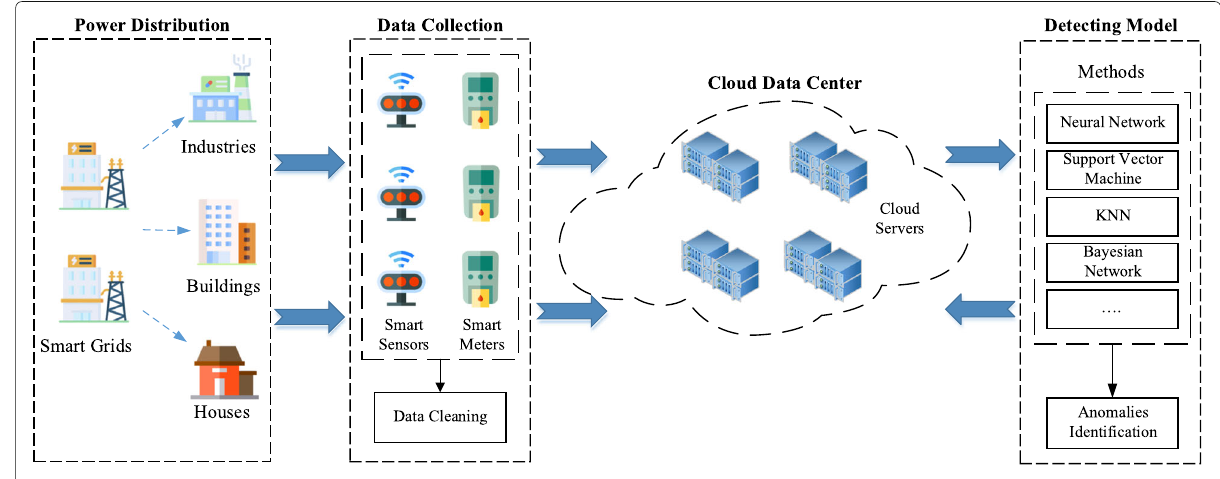
Fig. 1 The framework of anomaly detection for electricity consumption with cloud computing identify anomalous power consumption with high scala- bility, availability, and reliability. Main components of this framework are described as follows: 1) Data collection: Due to the improvement of industrialization and modernization, the amounts of power consumption are getting higher significantly. One of the big features of smart grids is the data explosion generated from meters or sensors. Compared with the conventional meters, the capability of smart meters is gathering electricity consumption from customers and appending more power information, including the values of voltage, phase angle, and frequency [62]. Smart meters can also read real-time electricity use and transmit these data to the energy providers. In our framework, the data collection phase contains three steps to collect higher accurate, complete, and consistent